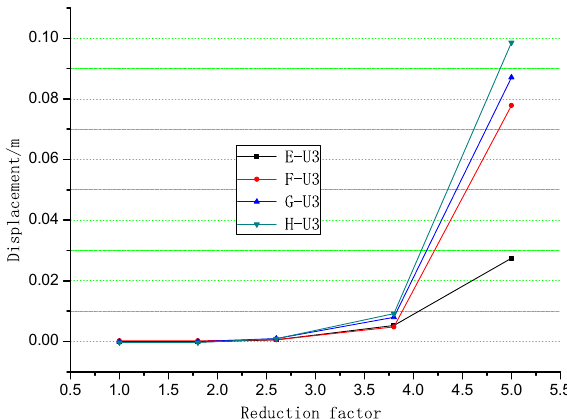
Figure 13. Displacement of monitoring points E to H vs. reduction factor in the z direction.